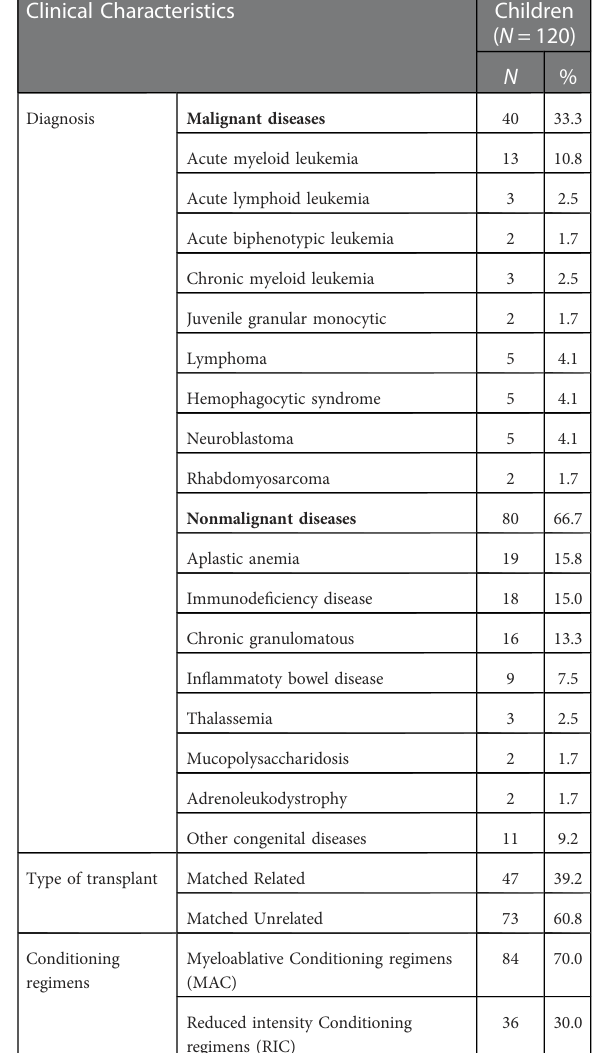
TABLE 2 Clinical characteristics of the